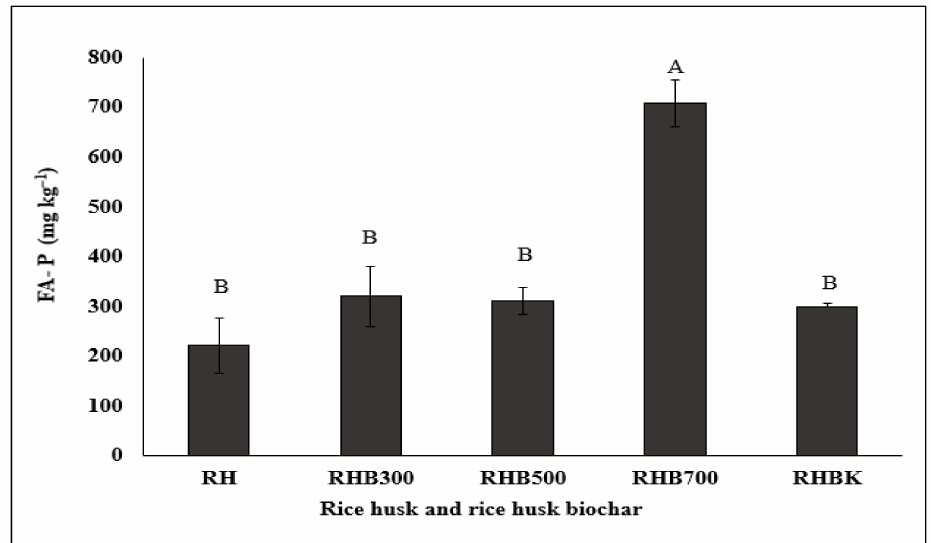
Figure 4. “Available” (i.e., formic acid-extractable) phosphorous (P) content of RH and RHB at different pyrolysis temperatures. Error bars are standard errors. Letters on top of error bars show significant difference at p ≤